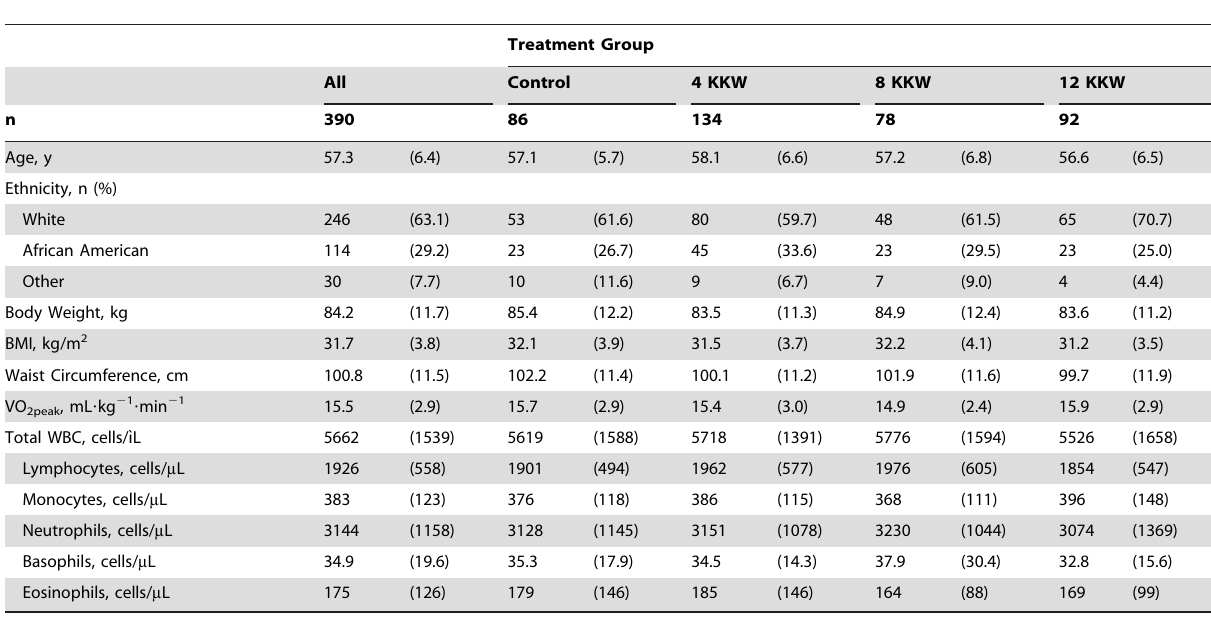
Table 1. Baseline participant characteristics and unadjusted leukocyte